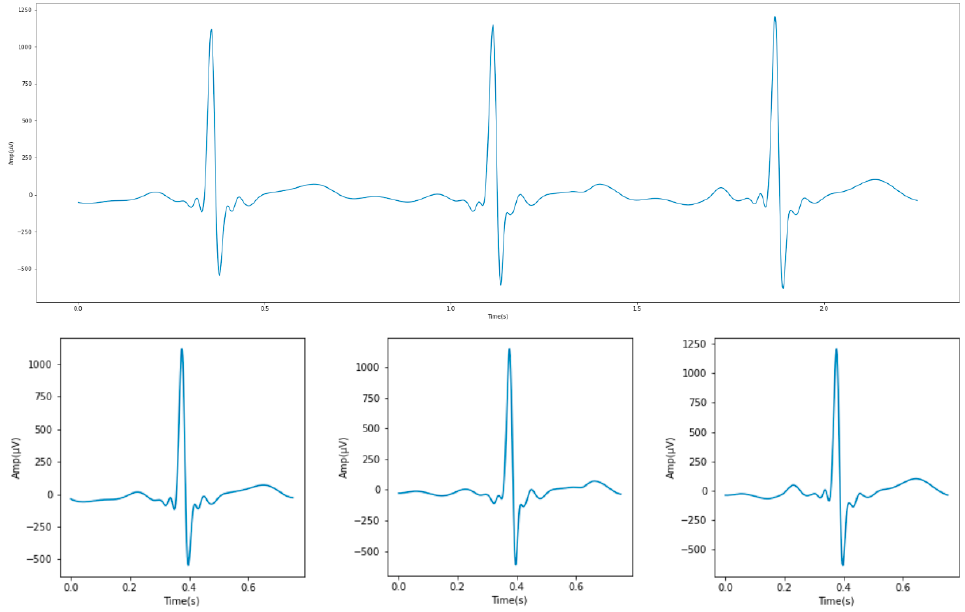
Figure 3. A single ECG waveform.